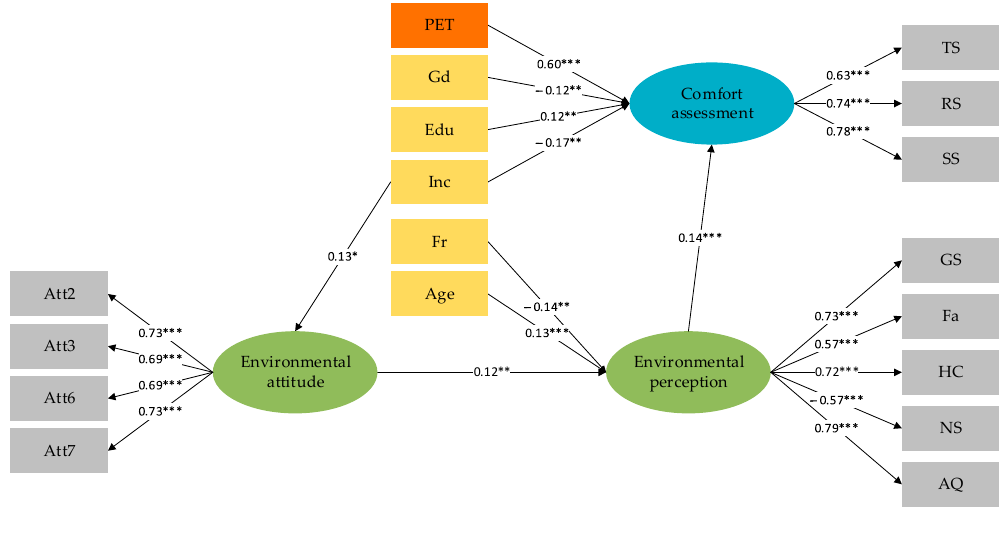
Figure 3. Diagram of SEM regarding comfort assessment in urban public spaces . Table 5. Verification result of hypothetical relationships.